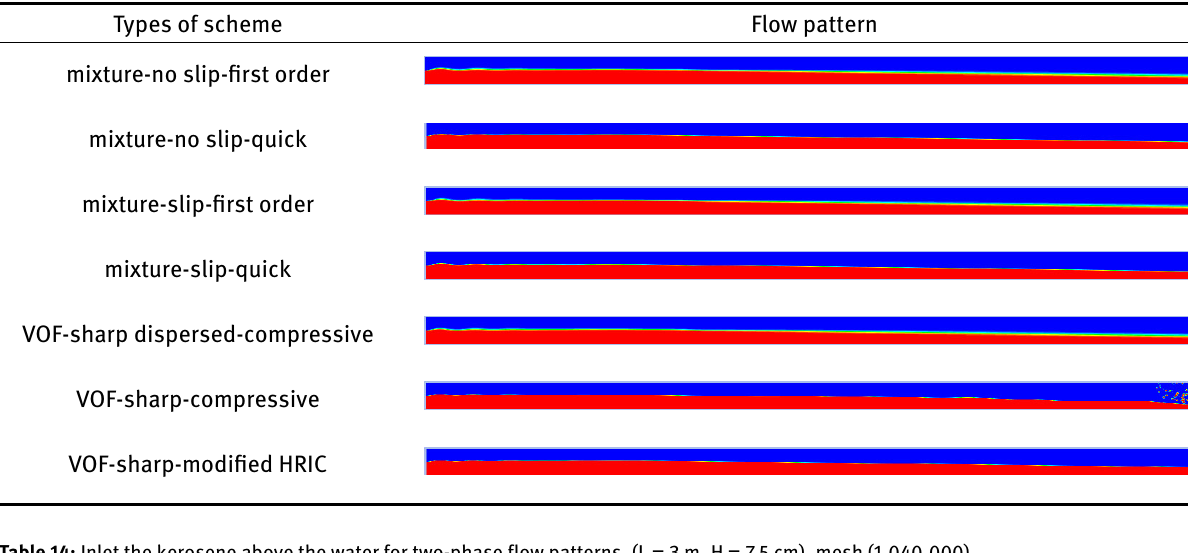
Table 14: Inlet the kerosene above the water for two-phase flow patterns, (L = 3 m, H = 7.5 cm), mesh (1,040,000) Types of